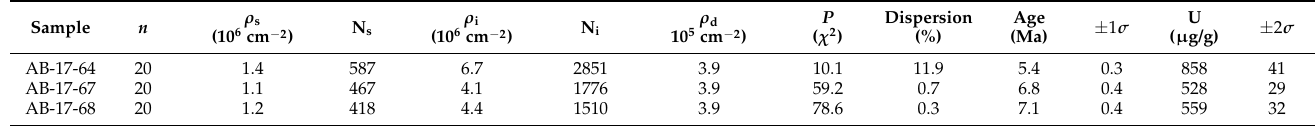
Table 2. Zircon fission track data 1 .